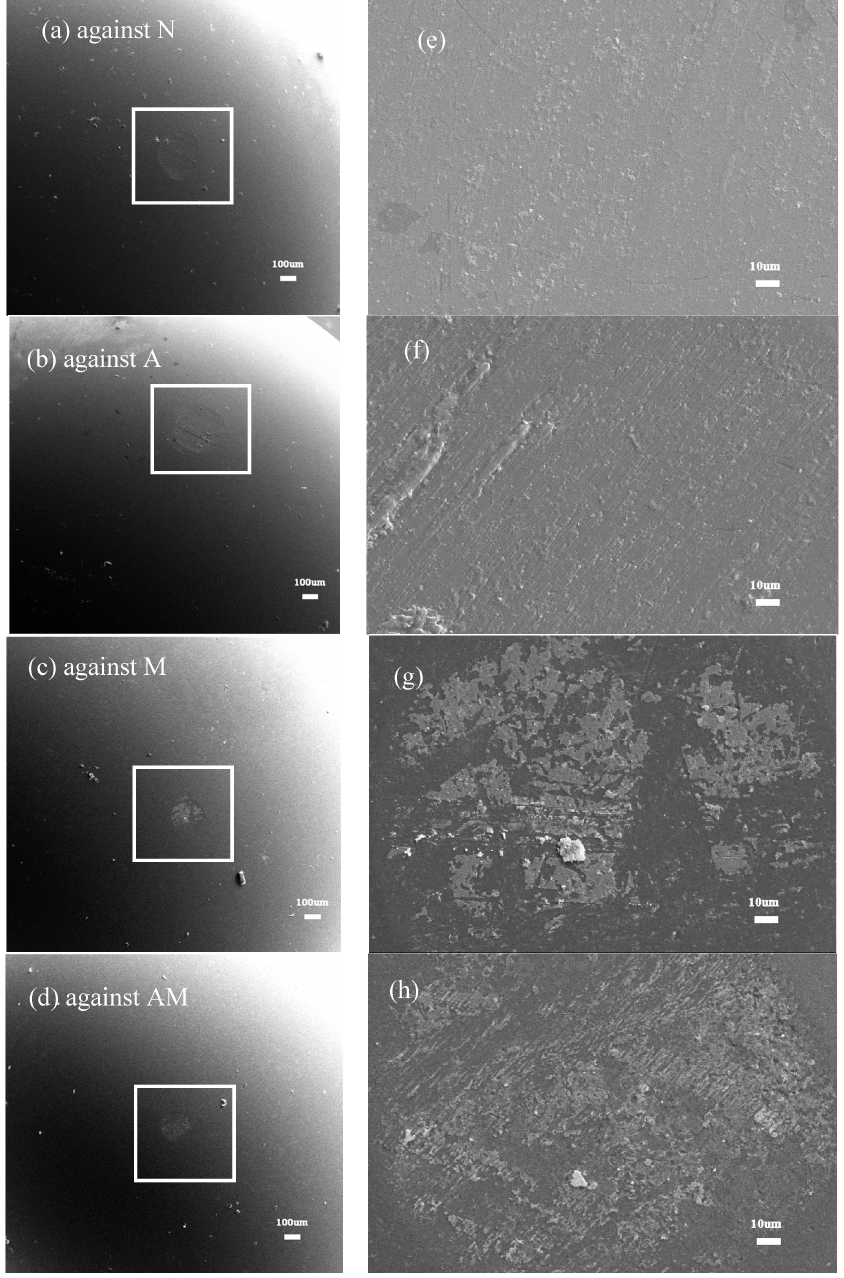
Figure 8. The SEM images of the counterface balls (Si 3 N 4 ball) after sliding against ( a ) A, ( b ) B, ( c ) C, and ( d ) D and corresponding higher magnification SEM images against ( e ) A, ( f ) B, ( g ) C, and ( h ) D.